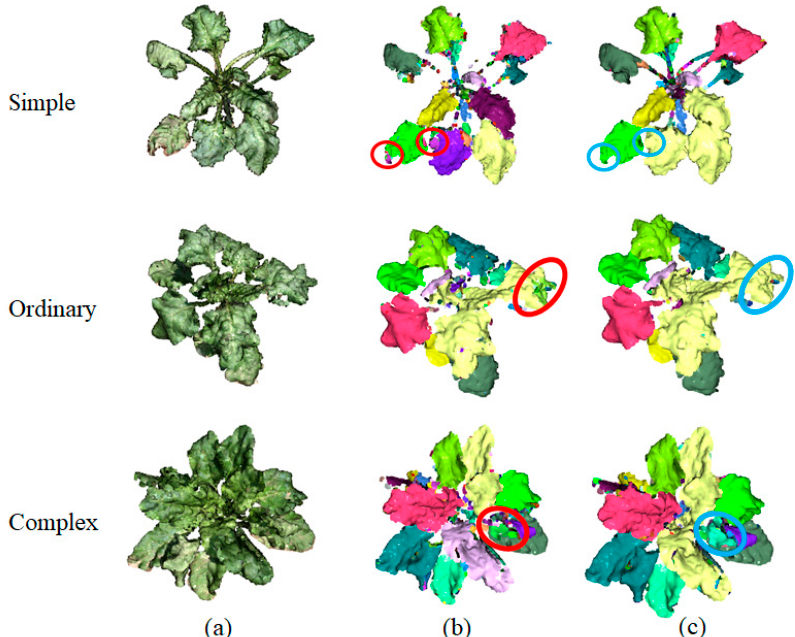
Figure 5. Visualization of point clouds segmentation for individual sugar beet plant by using the region-growing algorithm and MSTVM-based region-growing algorithm. The first row, the second row and the third row are one of the simple, ordinary and complex plant type structures, respectively. ( a ) are the individual sugar beet plants to be proceeded. ( b ) are the segmentation results based on the region-growing algorithm. Red circled area indicates incorrect segmentations. ( c ) are the segmentation results based on the MSTVM-based region-growing algorithm. Blue circled area indicates correct segmentations.